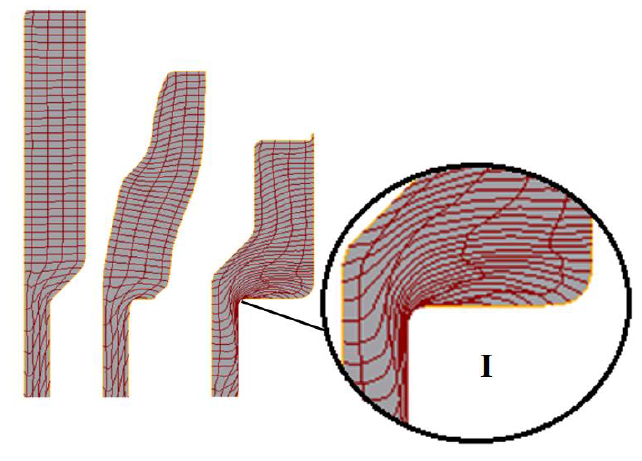
Figure 5. Simulation of the forming process via two steps.